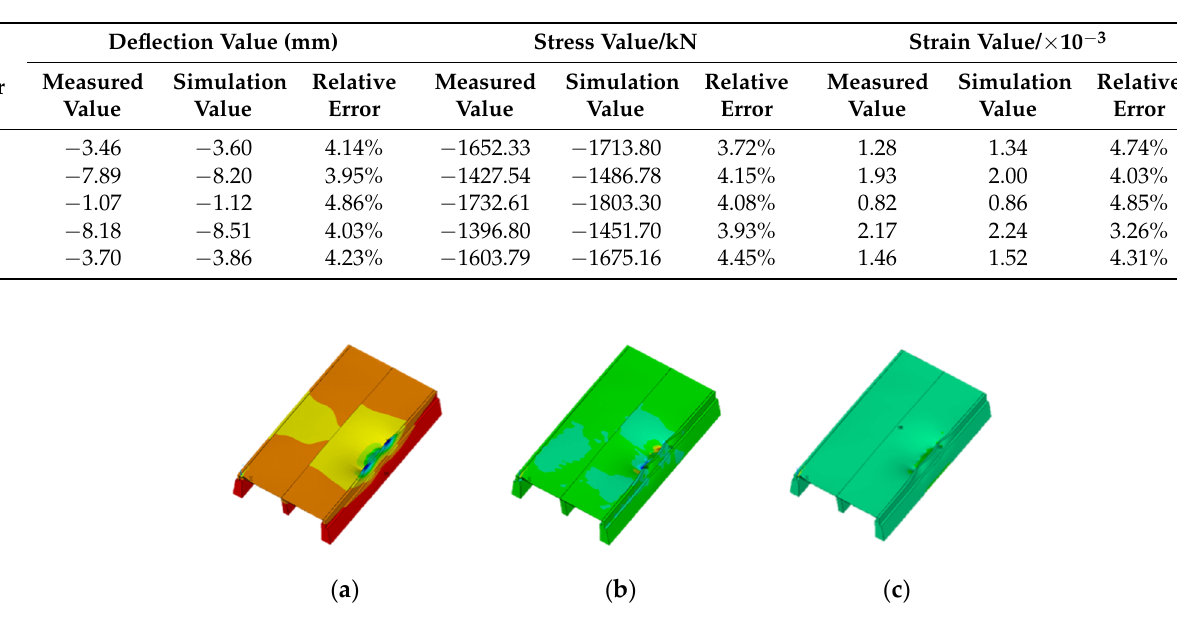
Figure 5. Cloud chart of bridge deformation loadings at point 1: ( a ) cloud chart of deflection; ( b ) cloud chart of strain; ( c ) cloud chart of stress.